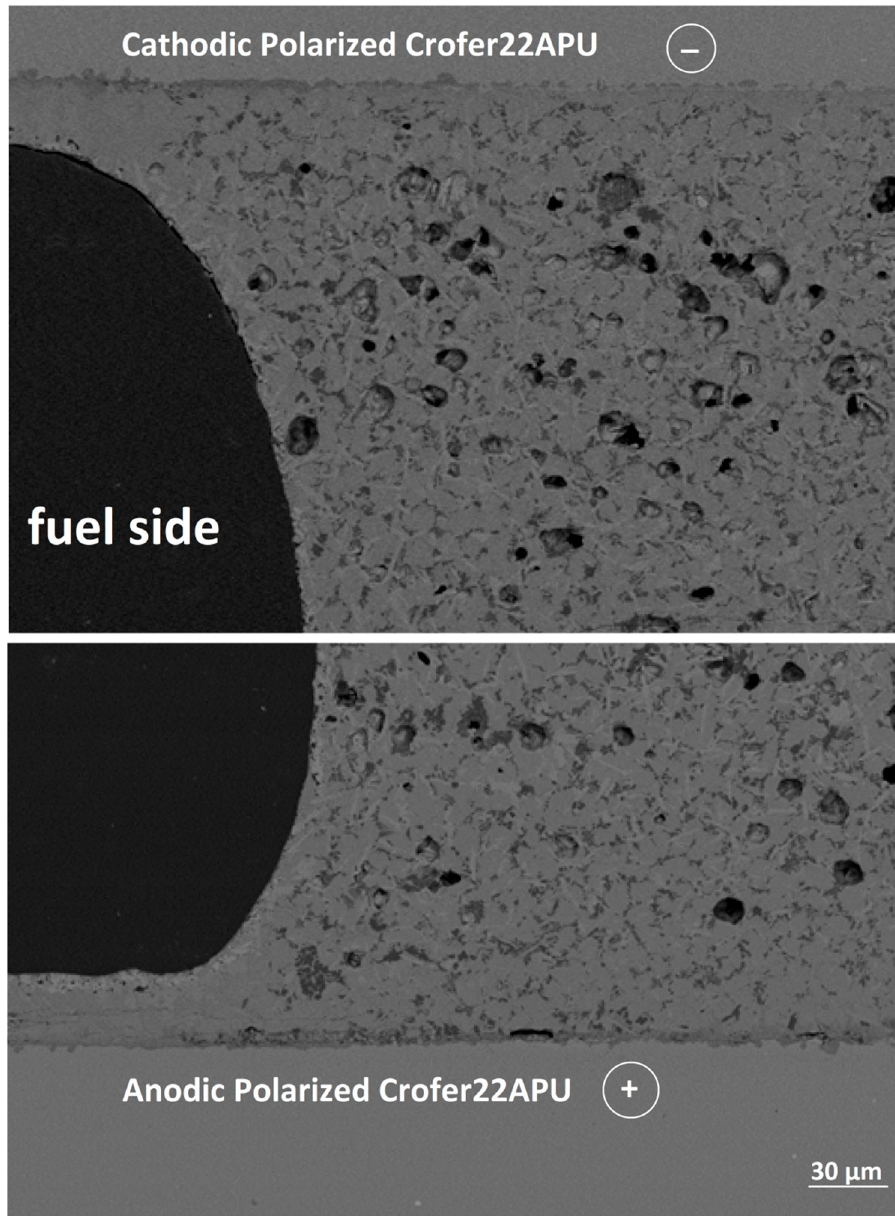
Figure 8. SEM ‐ EDS post mortem analysis at cathodic and anodic polarized Crofer22APU/HJ28 glass ‐ Figure 8. SEM-EDS post mortem analysis at cathodic and anodic polarized Crofer22APU / HJ28 ceramic interface after the dual test, collected at fuel side. glass-ceramic interface after the dual test, collected at fuel